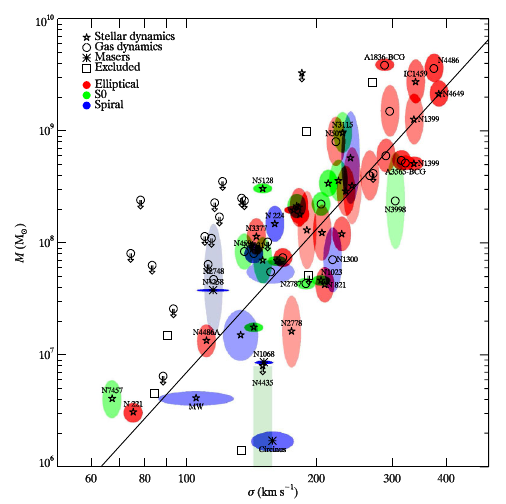
Fig. 4 Correlation between the mass of supermassive black holes and the velocity dispersion of their host galaxies.